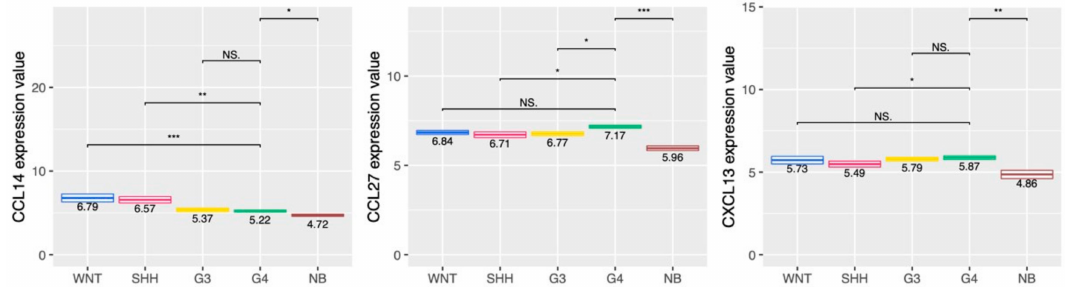
Figure 6. Expression of CCL14, CCL27, and CXCL13 in different MB subgroups, tumors and normal brain. The expressions of CCL14, CCL27, and CXCL13 among 4 subgroups of MB tumors and normal brain tissue were analyzed from the transcriptome data. *, p < 0.05; **, p < 0.01; ***, p < 0.001, compared to G4 subgroup tumors. NS: no significant